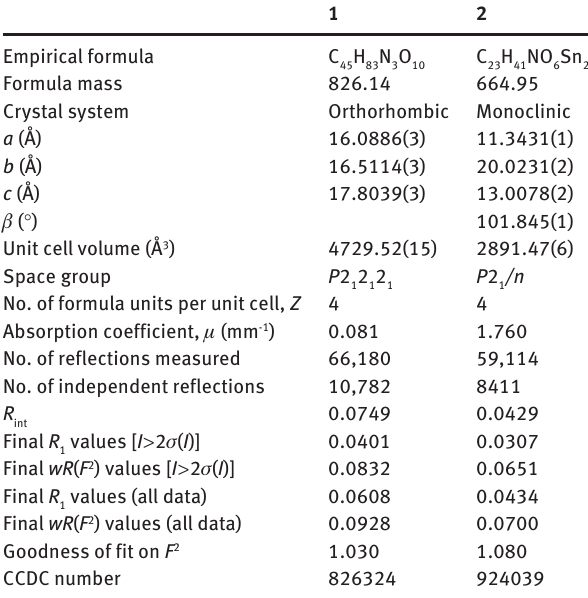
Table 2 Crystallographic data for compounds 1 and 2